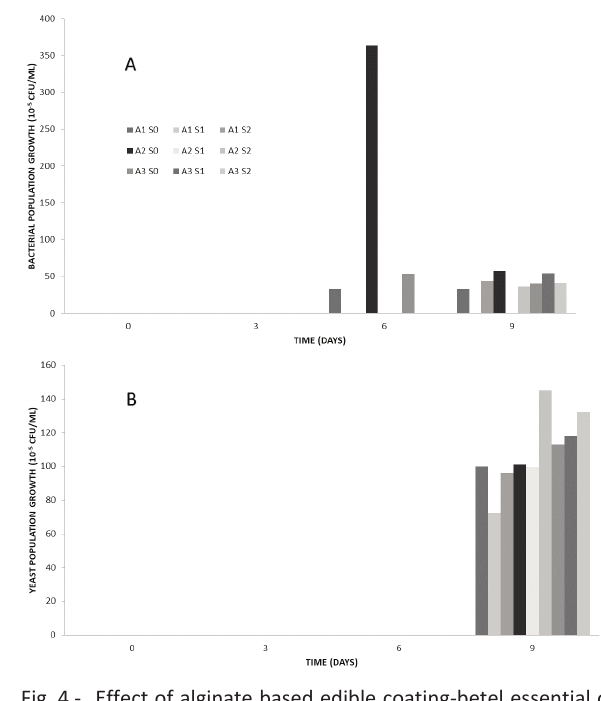
Fig. 4 - Effect of alginate based edible coating-betel essential oil on bacteria (A) and yeast (B) population of rose-apple.